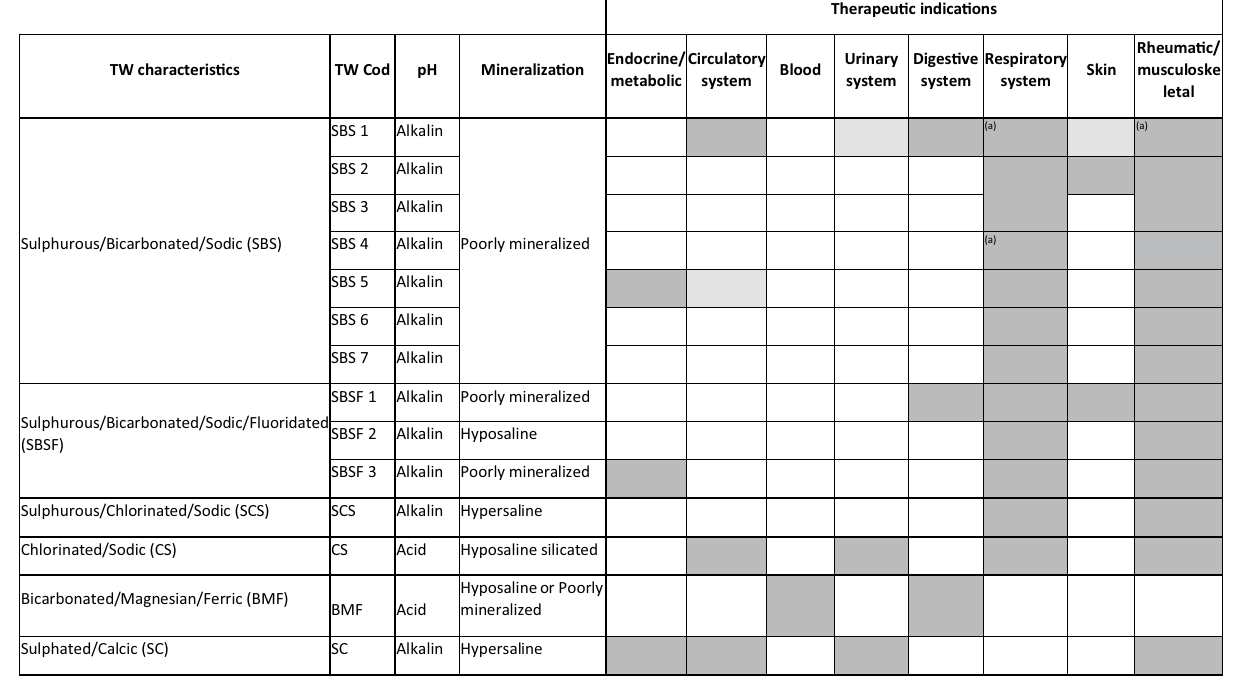
Table 2. Characterization and therapeutic indications of TW used in this study. Adapted from 4,15–17 . Cod codification: dark grey rectangles—according to Direção-Geral da Saúde (1989) 16 and Termas de Portugal (2019) 17 ; light grey rectangles—according to Termas de Portugal 17 . (a) Not indicated by Termas de Portugal 17